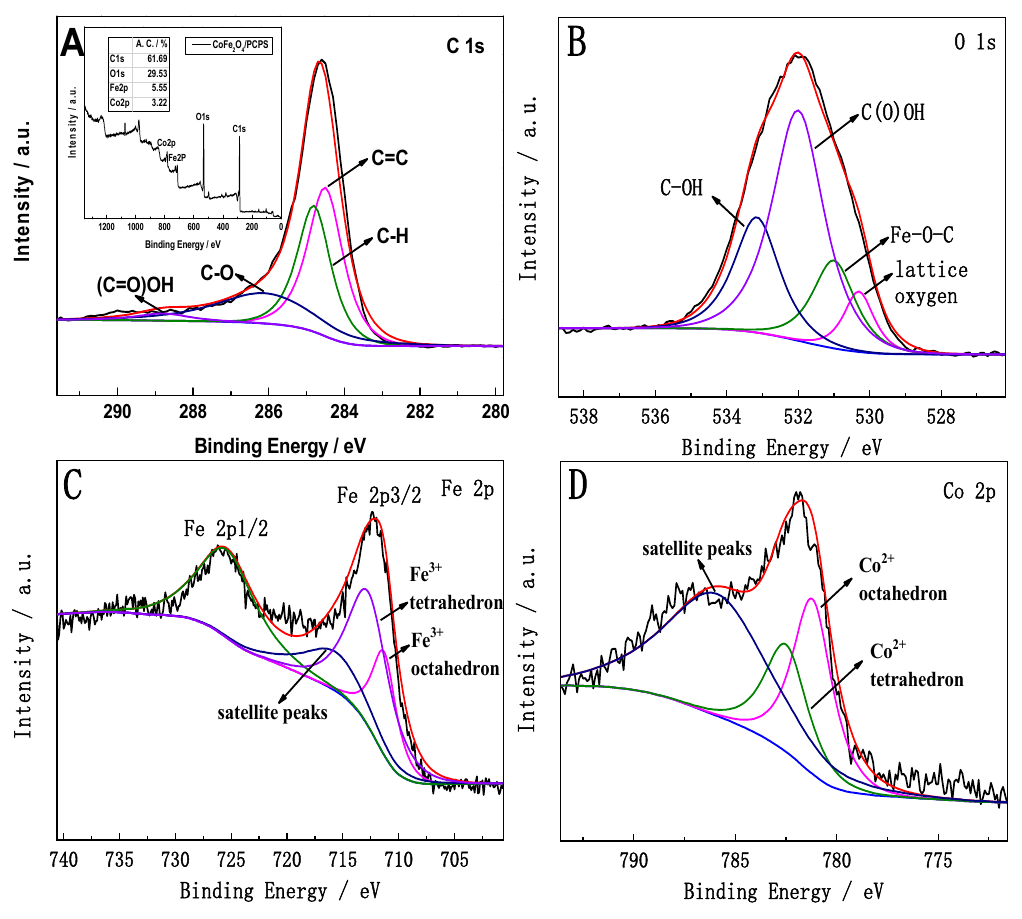
Figure 5. XPS for CoFe 2 O 4 /PCPS: full scan spectra [the inset in ( A )], C 1s spectra ( A ), O 1s spectra ( B ), Fe 2p spectra ( C ), and Co 2p spectra ( D ).